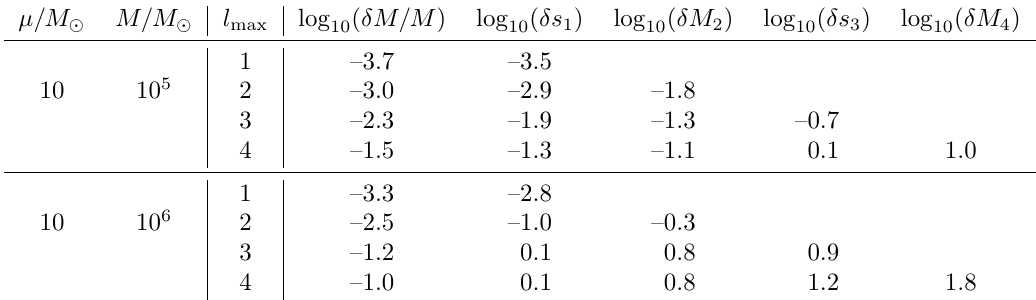
Table 3: Accuracy with which a LISA observation could determine the multipole moments of a spacetime decreases as more multipoles are included in the model, taken from Ryan [388]. The third column indicates the highest multipole included in the particular model. Results are shown for two typical cases, a 10 𝑀 ⊙ + 10 5 𝑀 ⊙ inspiral and a 10 𝑀 ⊙ + 10 6 𝑀 ⊙ inspiral; in both cases the SNR of the inspiral is